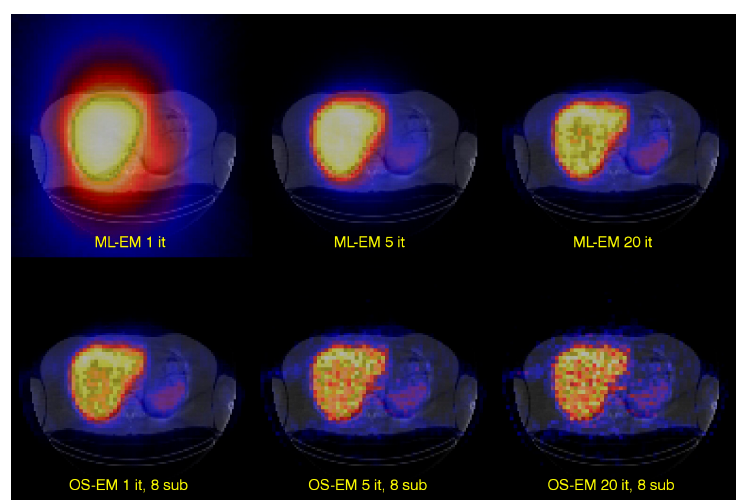
Figure 3. The figure shows tomographic images of the 111 In-labeled monoclonal antibody distribution in the liver. The upper row shows images reconstructed with ML-EM and where one, five and 20 iterations have been used. The lower row shows corresponding images reconstructed with OS-EM.